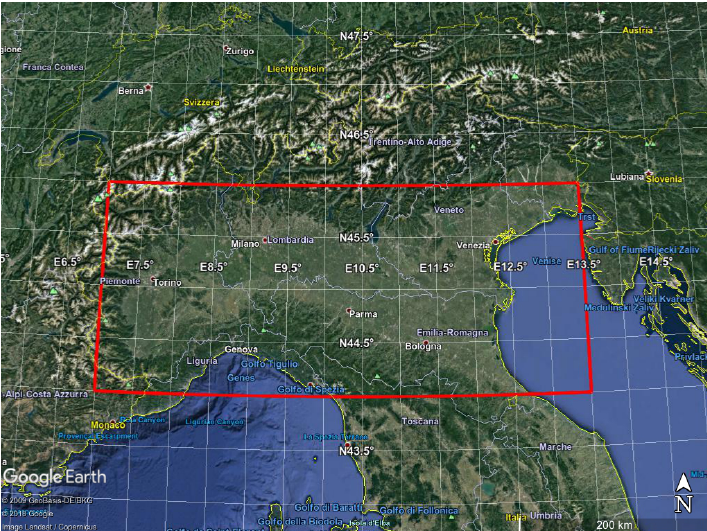
Figure 3. IASI target area over Po-Valley (red rectangle) used to check the retrieval